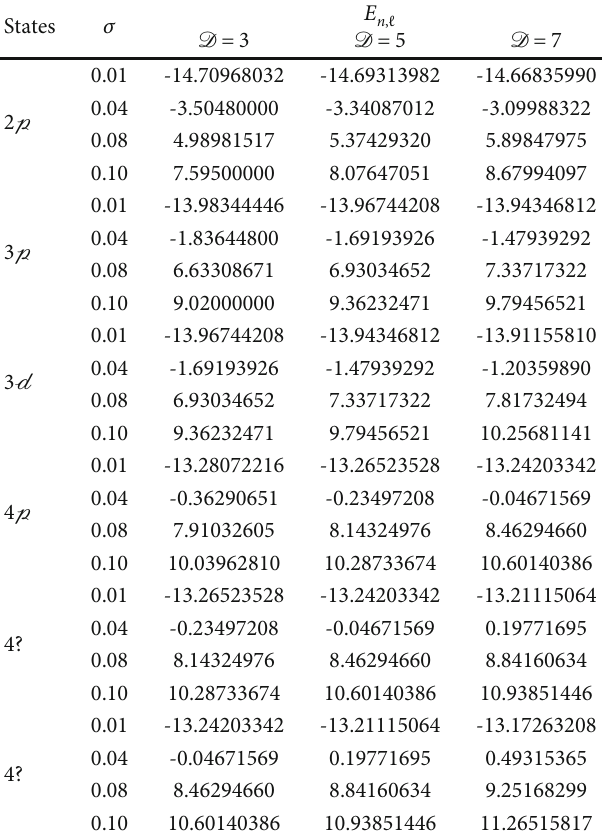
n , ℓ as a function of